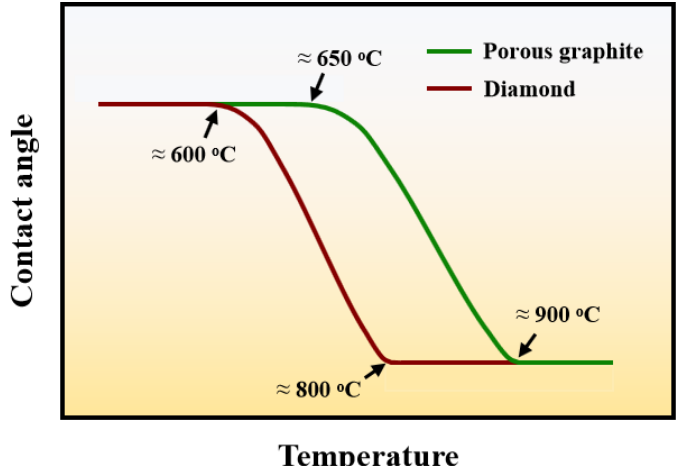
Figure 12. Apparent contact angles of Sn-V alloys on porous graphite and CVD diamond plotted at constantly elevated temperatures up to 950